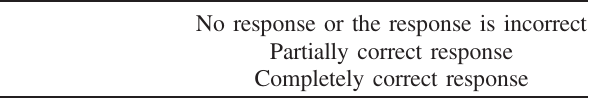
TABLE III. Example of a scoring rubric for an item.